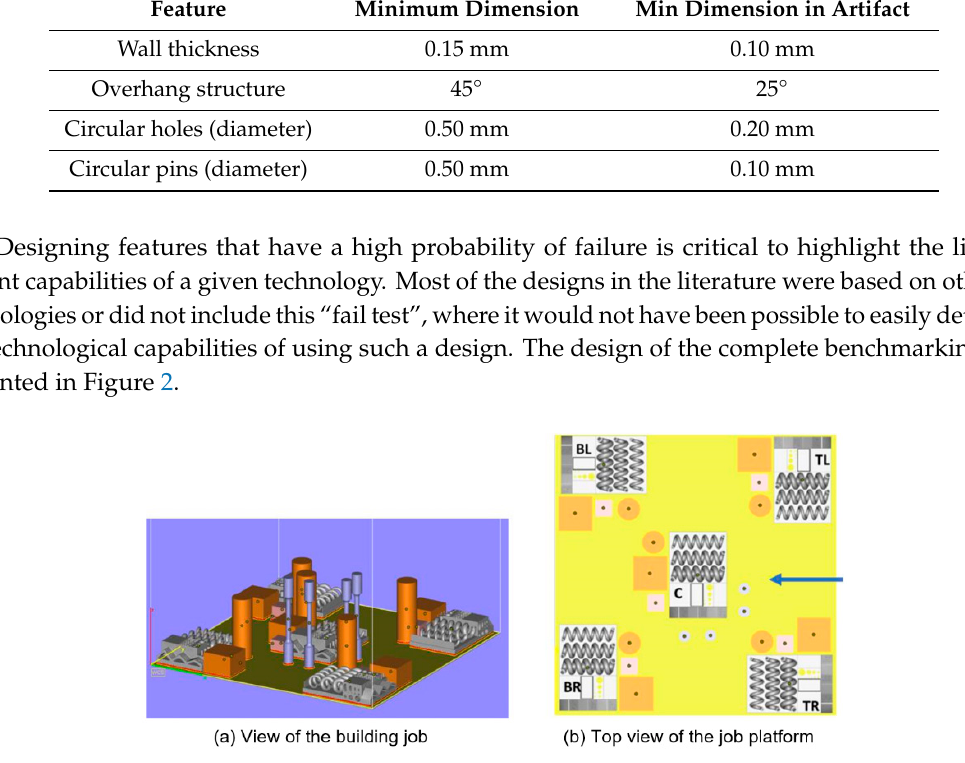
Figure 2. View of one complete platform of benchmarking building job. ( a ) View of the full building job; ( b ) Top view of the building platform [27].